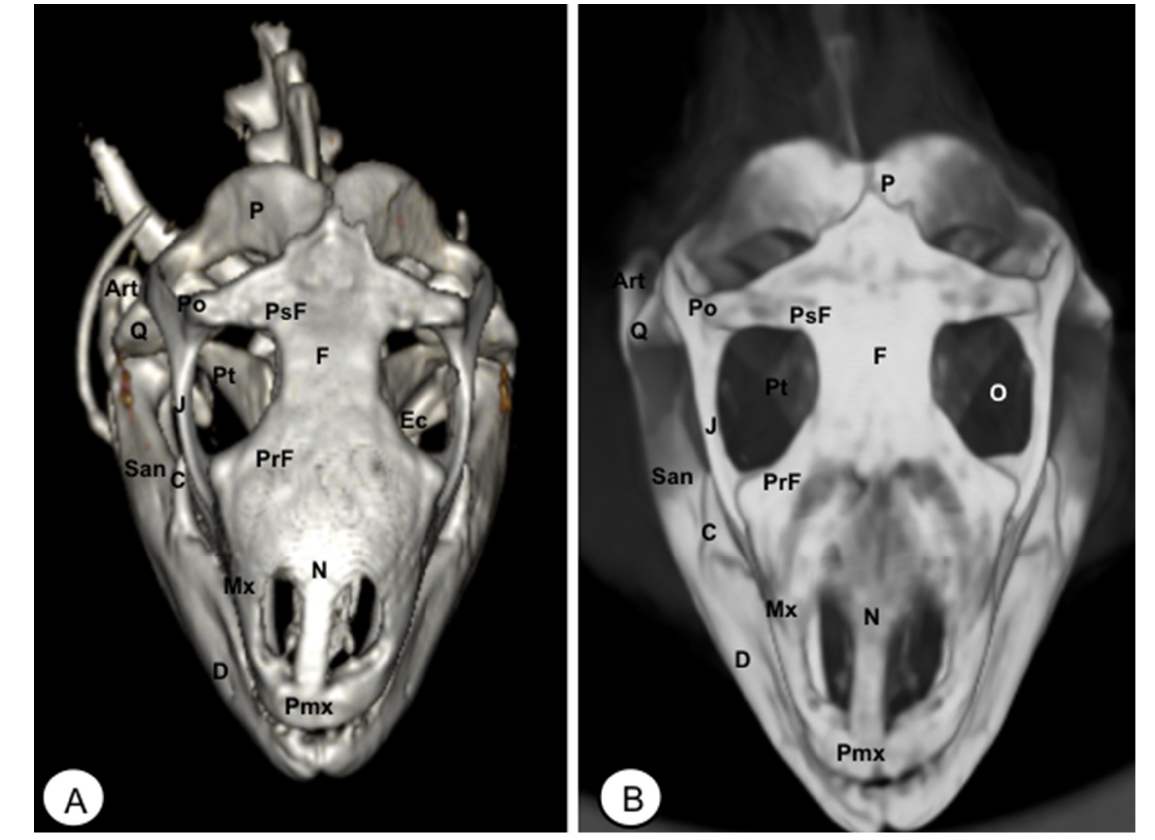
Figure 7. Head of Iguana iguana . ( A ) Rostral VR image. ( B ) Rotral MIP image. N: Nasal. Pmx: Premax-